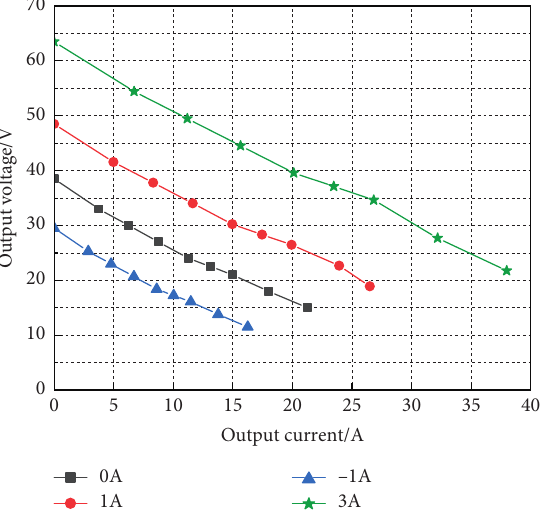
Figure 21: Load characteristics of the PMCHEG.